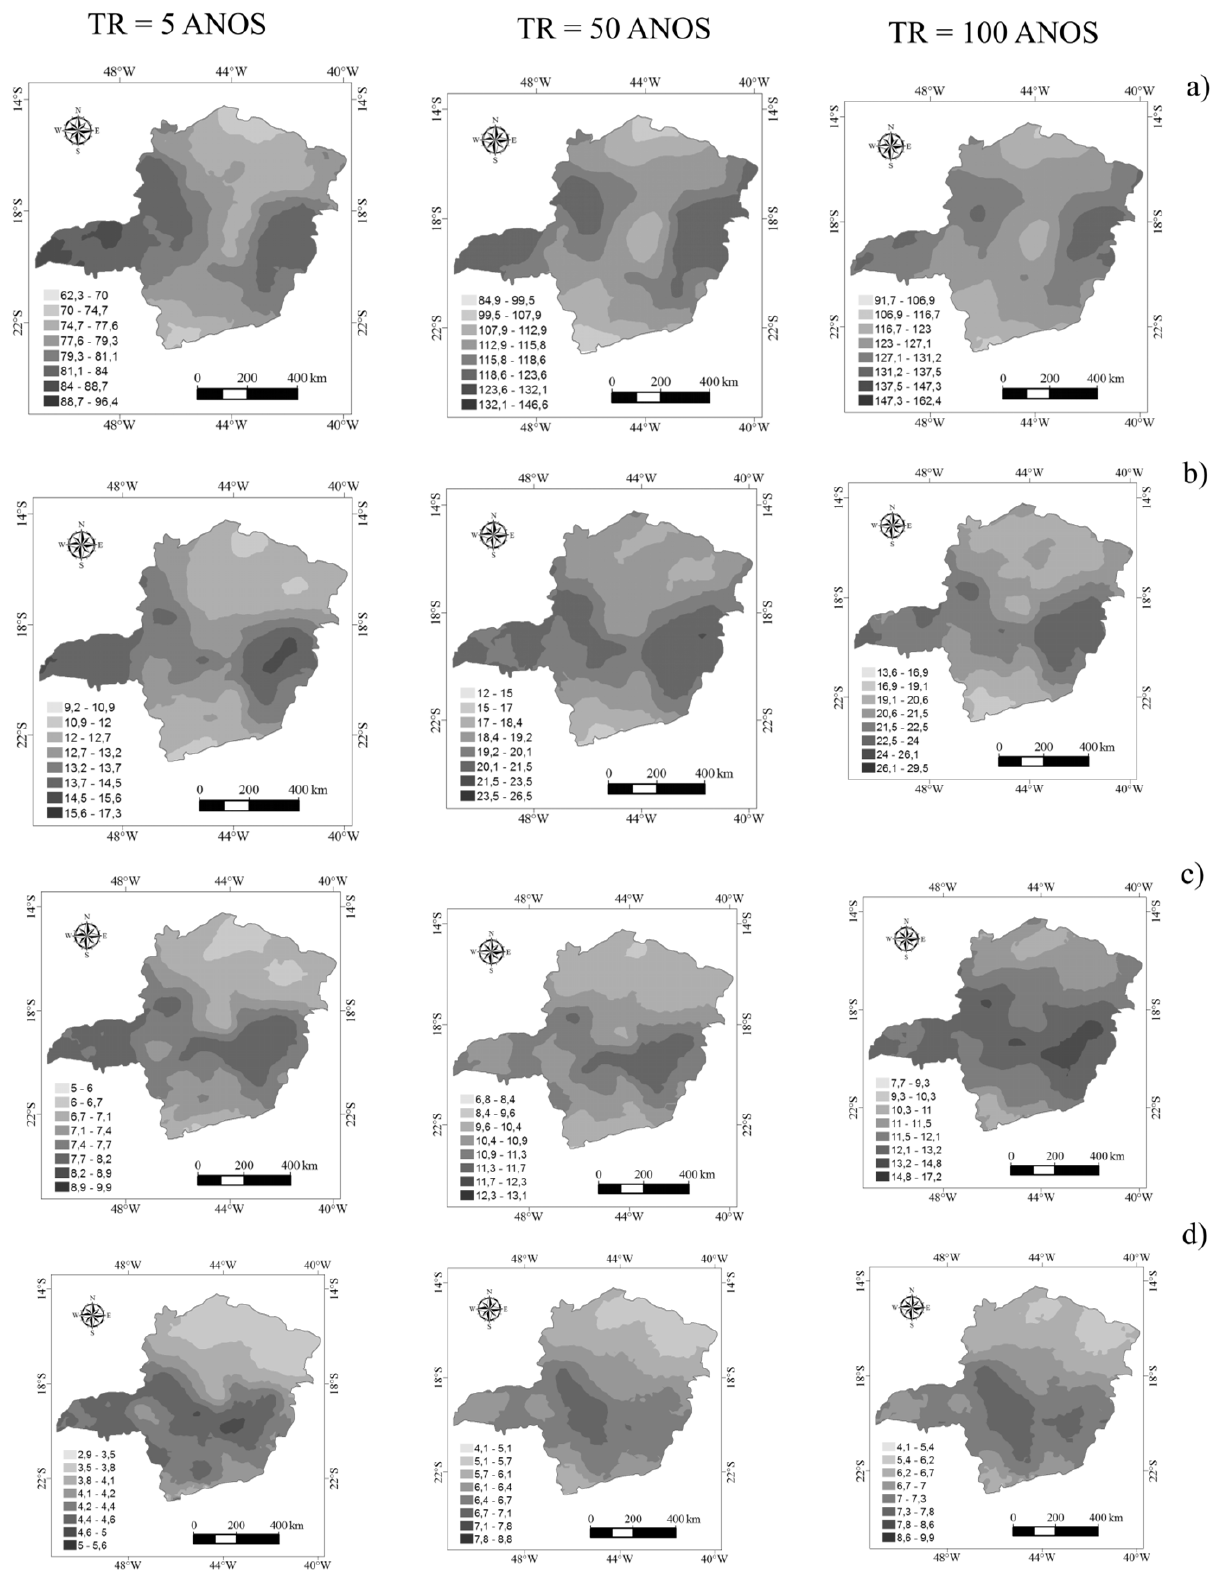
Figura 3. Mapas de cokrigagem com a altitude como variável secundária, para diferentes chuvas intensas para o Estado de Minas Gerais: (a) 30 min de duração; (b) 360 min; (c) 720 min; e (d) 1.440